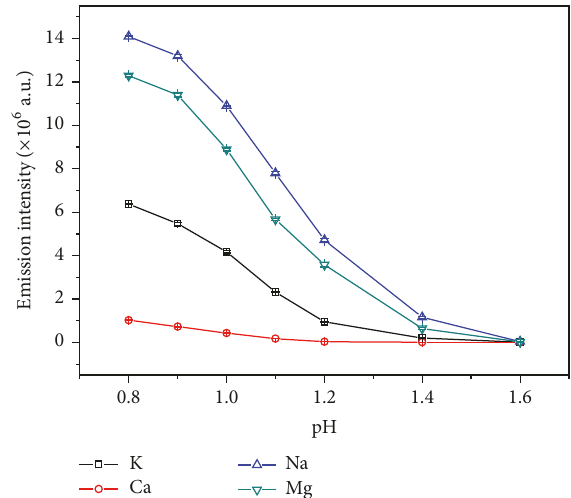
Figure 5: Effect of solution flow rate on emission intensity (elec- trolytes: 5 mgL −1 K, Ca, Na, and Mg solution adjusted to pH = 1.0 with HNO 3 , discharge voltage: 650 V, interelectrode gap: 2 mm, and capillary diameter: 1mm).